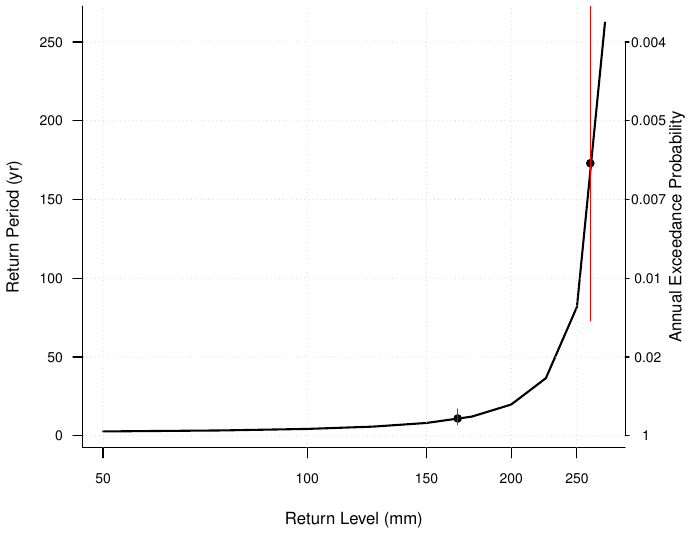
Figure 11. Tropical cyclone rainfall return frequency for Miami, Florida. Return level in mm is shown on the x-axis, return period in years is shown on the y-axis. Annual probability is also included. Red lines about the points indicate confidence bounds at the 90th percentile. Points indicate the 90th percentile rainfall amount and Hurricane Irene in